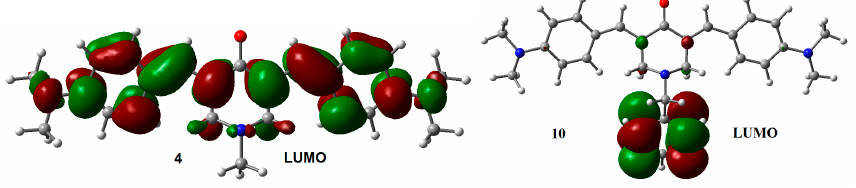
Figure 4. LUMO for adiabatic radical anions 4 and 10. Isosurface value = 0.02 e/Å 3 .